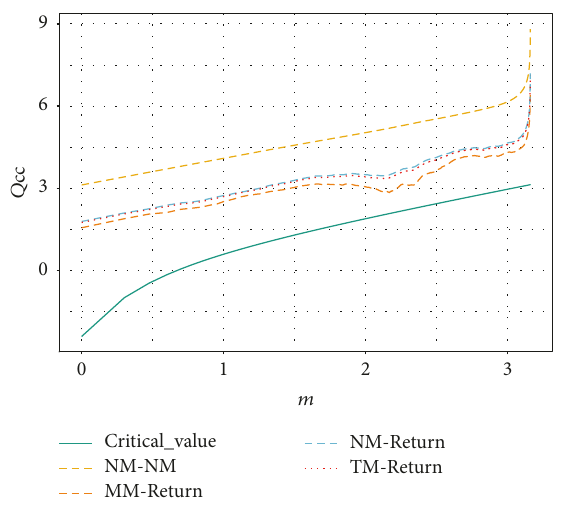
Figure 2: Cross-correlation test (𝑄 cc (𝑚)) .